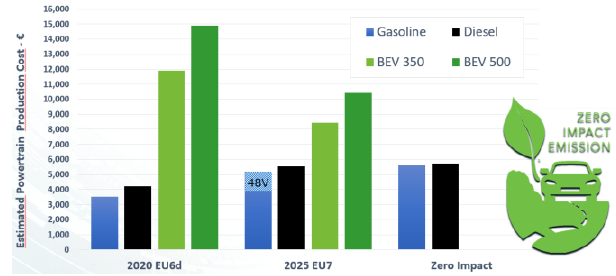
Fig. 4. Estimated production costs (in Euros) for gasoline, diesel and battery electric powertrains [29]